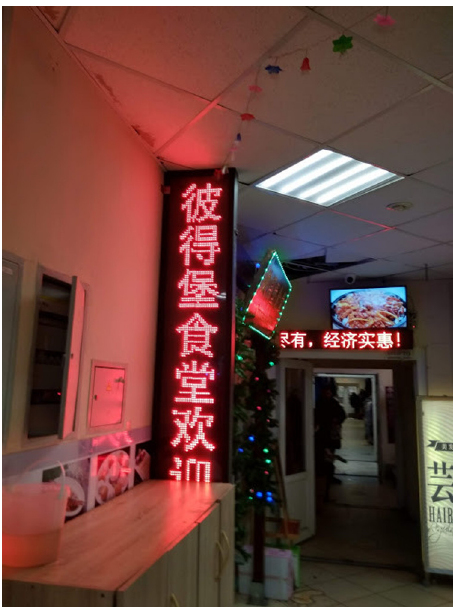
Figure 9: Chinese beauty salon, Apraksin dvor, St. Petersburg, 2016, LinguaSnapp SPb.